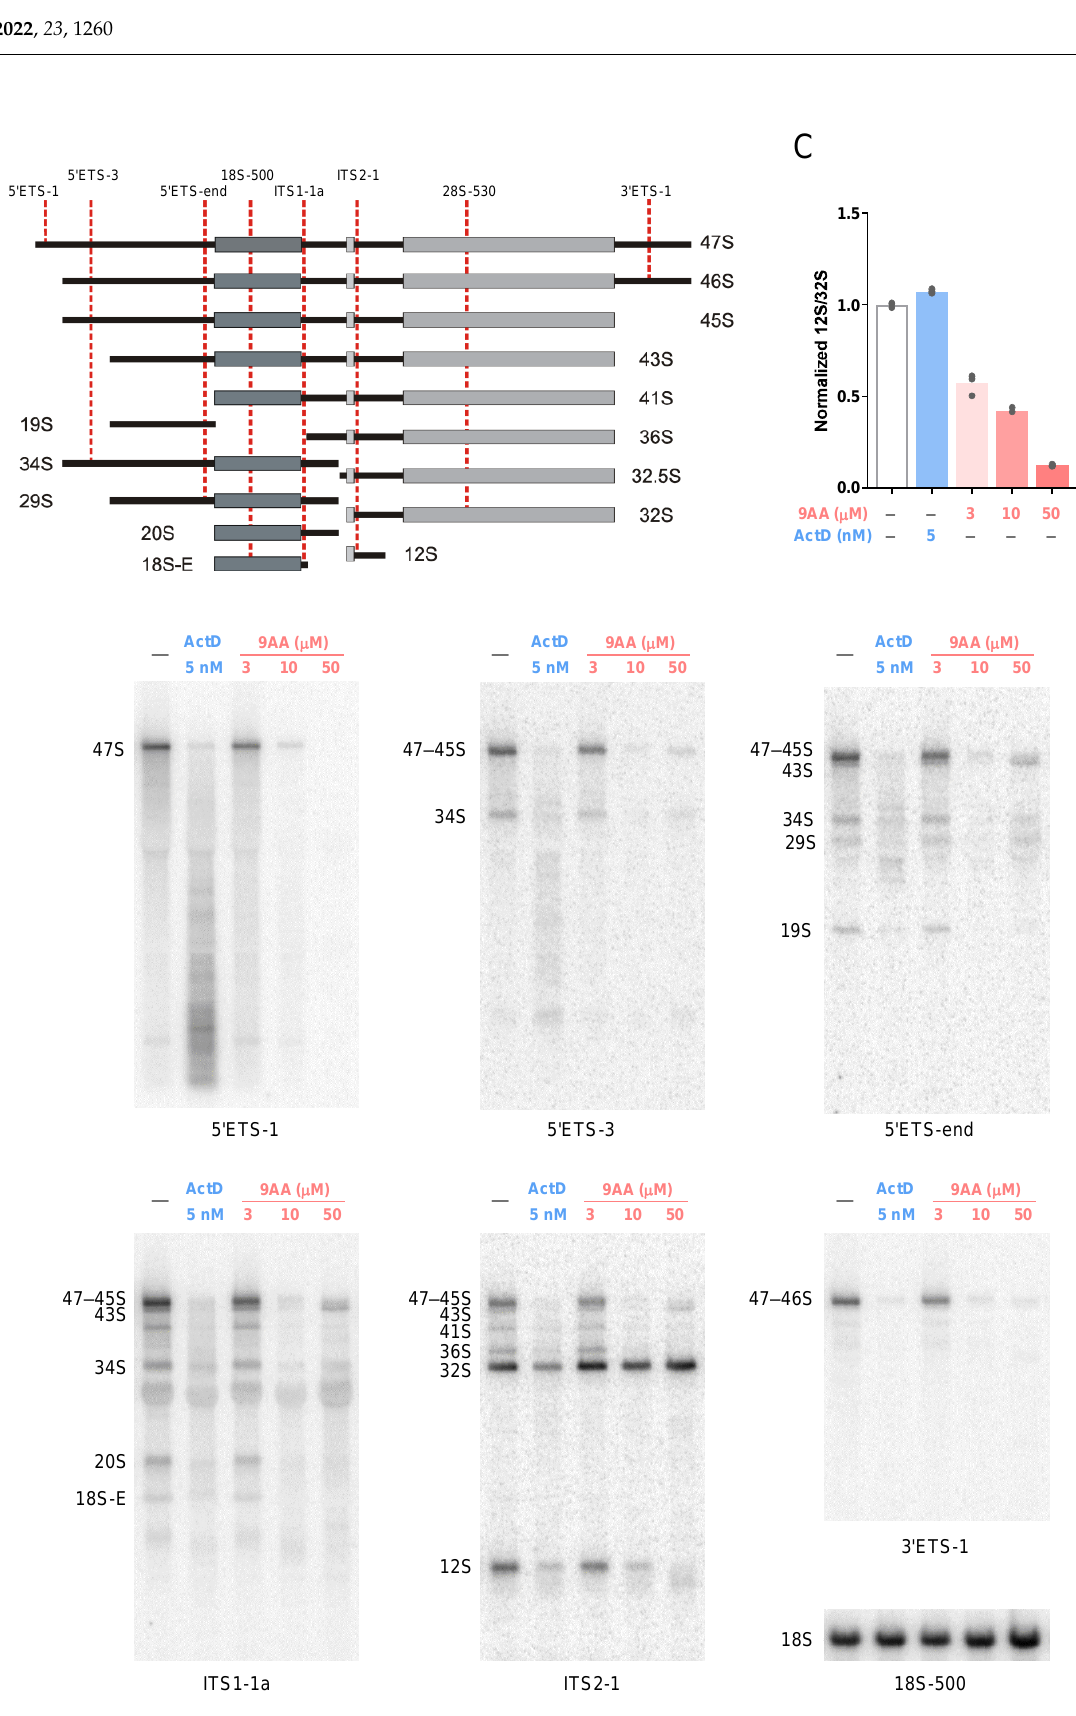
Figure 4. 9AA inhibits pre-rRNA processing. ( A ) Major rRNA precursors in mouse cells. Oligonu- cleotide probes used for the detection of pre-RNAs via hybridizations are diagrammed at the top. Probe sequences are listed in Table S1. ( B ) Hybridization analysis of pre-rRNA. NIH 3T3 cells were treated with ActD or 9AA for 2 h. Total cellular RNA was extracted, resolved on a 1% agarose gel, and transferred onto a nylon membrane. The membrane was sequentially hybridized with the